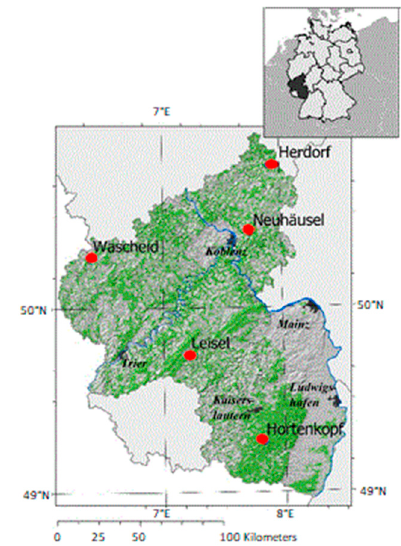
Figure 1. Geographic position (red dots) of the twinned Level II forest sites and their associated ZIMEN monitoring stations in Rhineland-Palatinate (Germany).